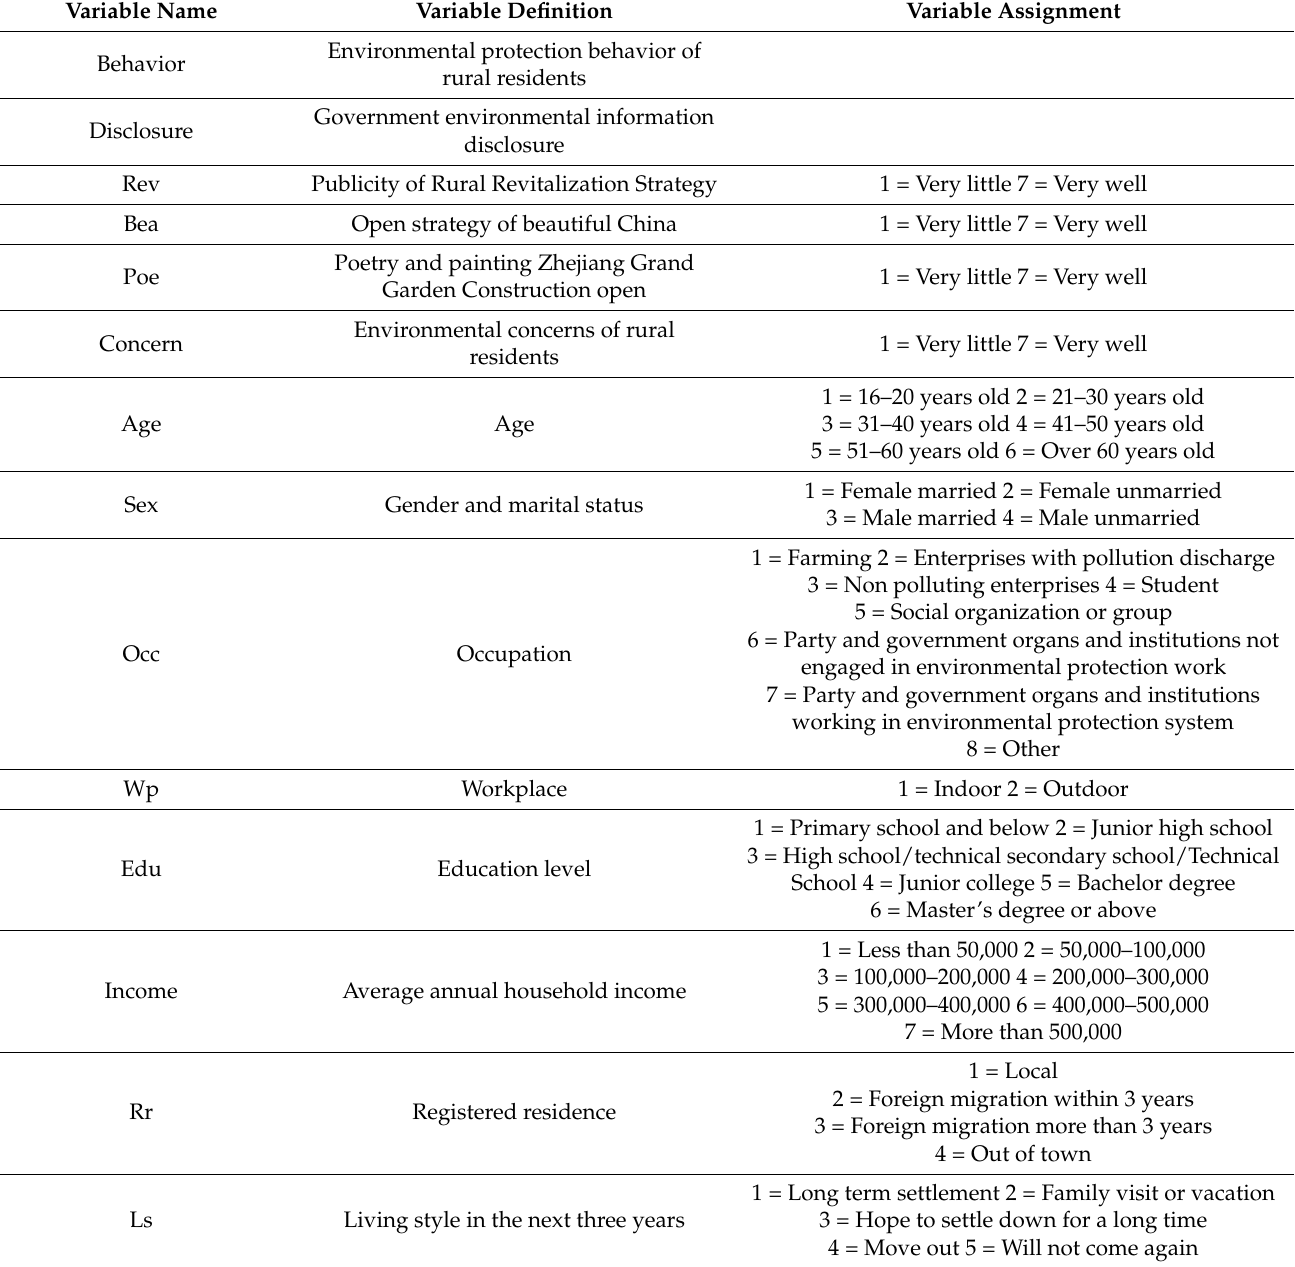
Table 1. Definitions and operations of